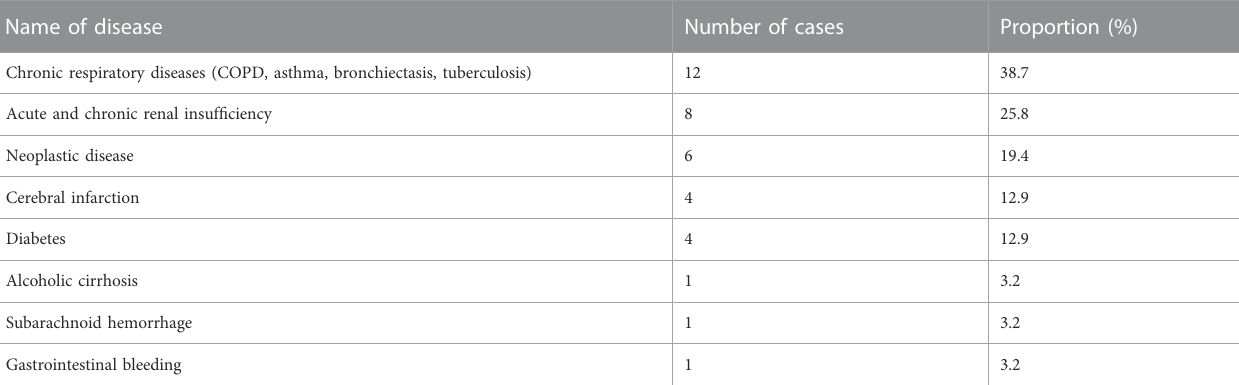
TABLE 1 Basic diseases of patients with C. psittaci pneumonia.